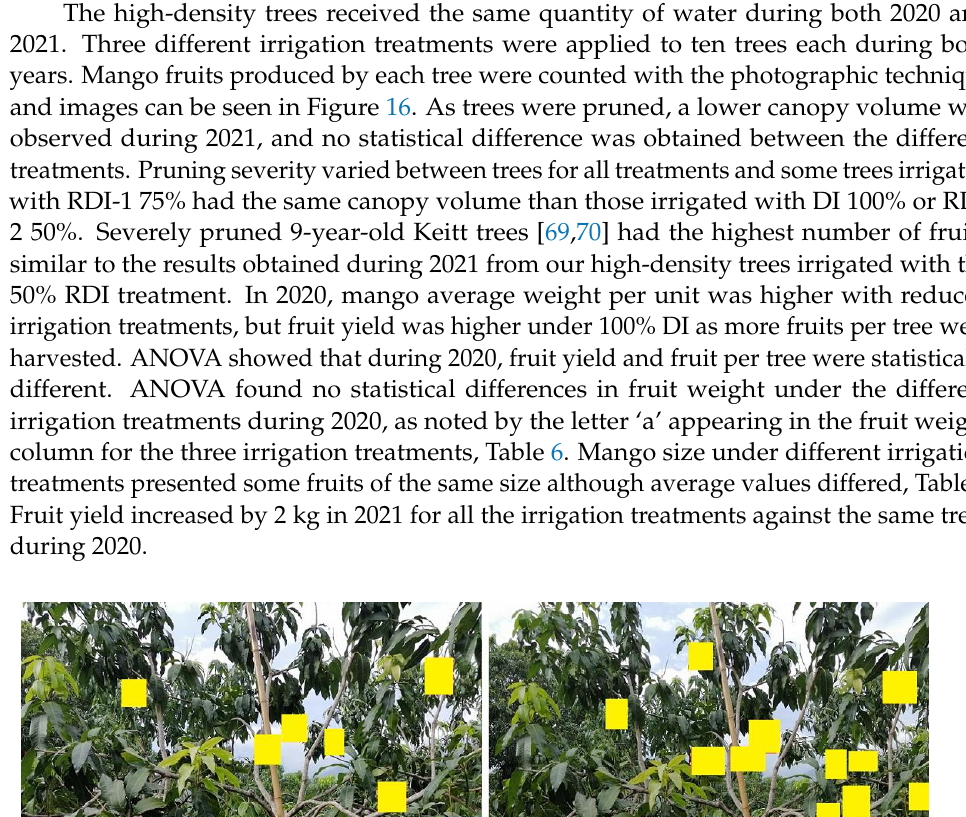
Table 6. Average fruit yield, fruit per tree, fruit weight, water applied, canopy volume and WUE for each irrigation treatment during 2020 and 2021 for HD trees.